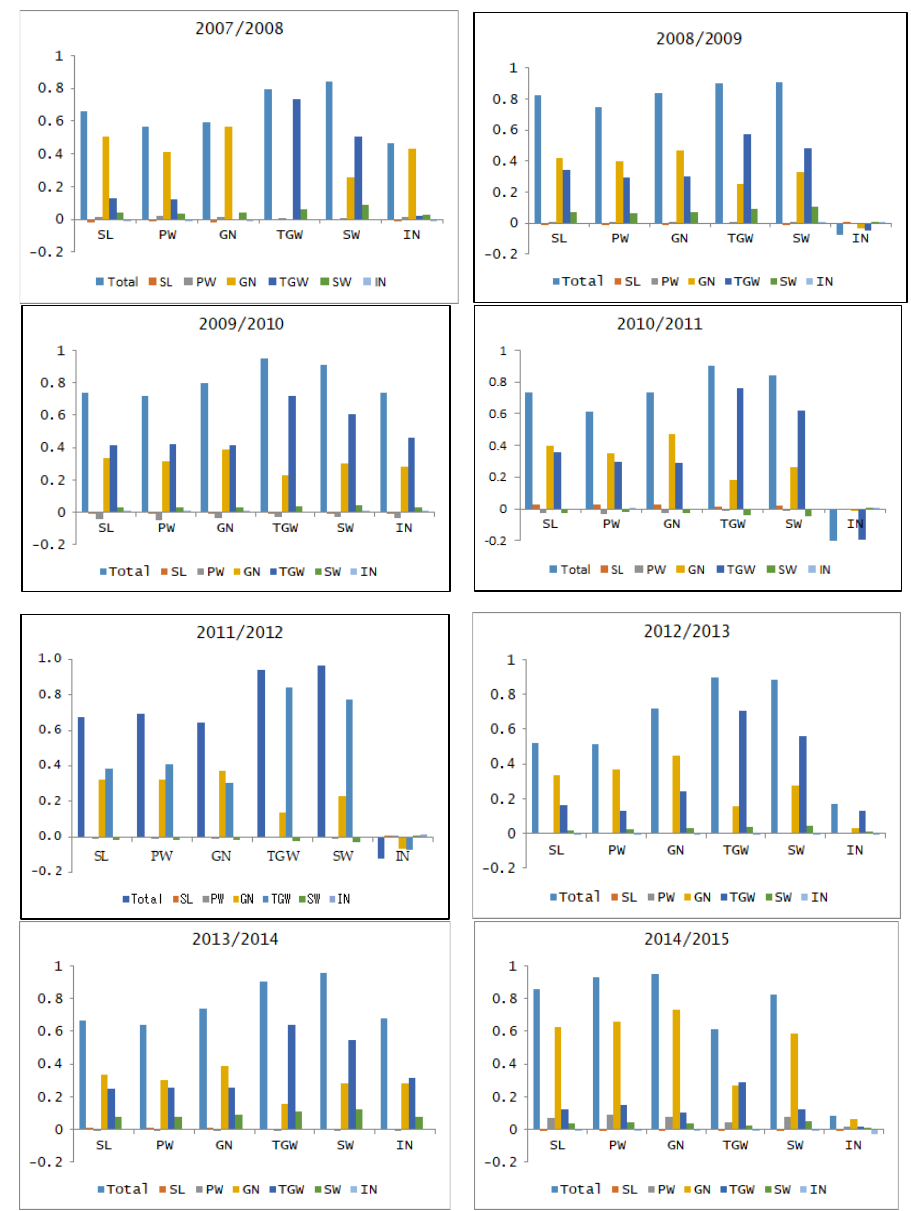
Figure 6. Interrelation of biometrical parameters of yield.